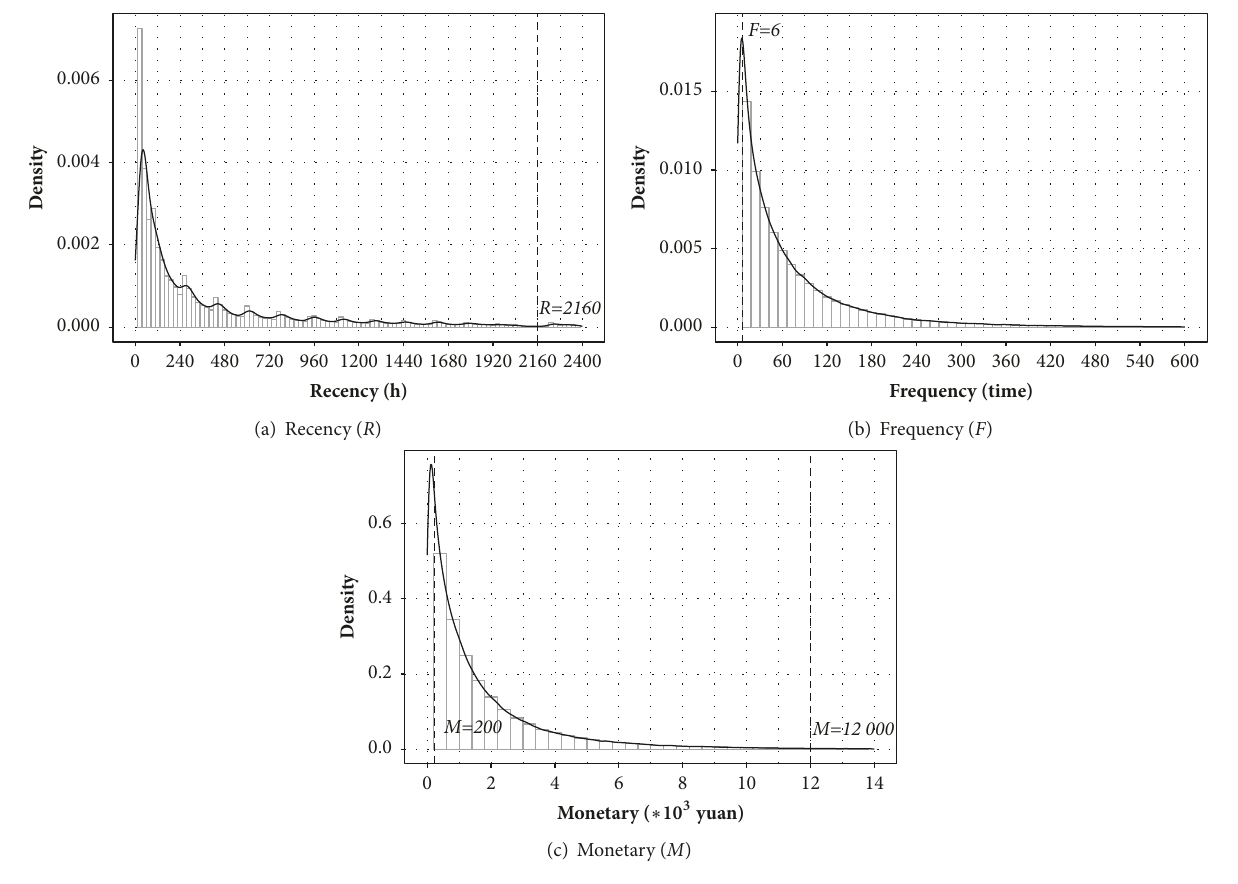
Figure 2: Distribution of ETC customer segmentation index.